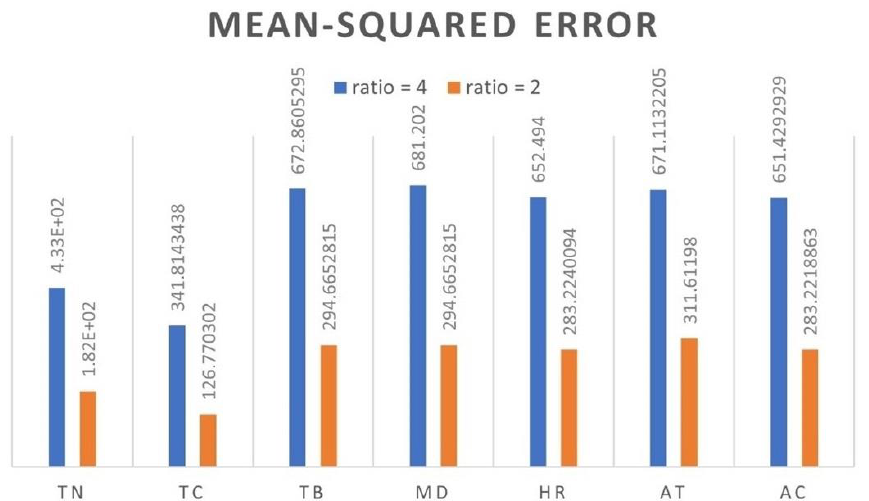
Figure 10. Average MSE: traditional nearest neighbor (TN), traditional bicubic (TC), traditional bilinear (TB), normalized minimum side-based diameter-based (MD), normalized hypotenuse radius-based (HR), normalized virtual pixel length-based height for the area of the triangle-based (AT), and normalized virtual pixel length for hypotenuse-based radius for the area of the circle (AC) interpolation algorithms.